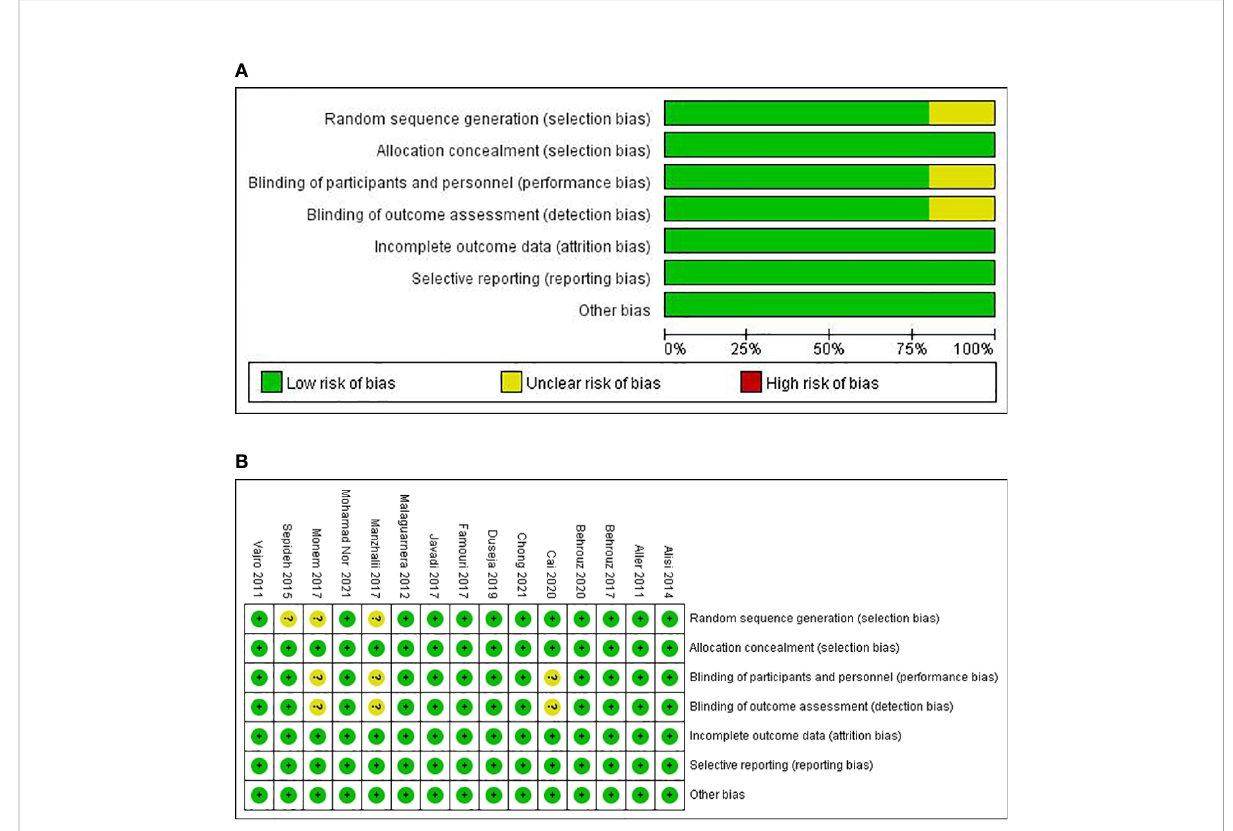
FIGURE 2 Risk of bias graph (A) and risk of bias summary (B) for included